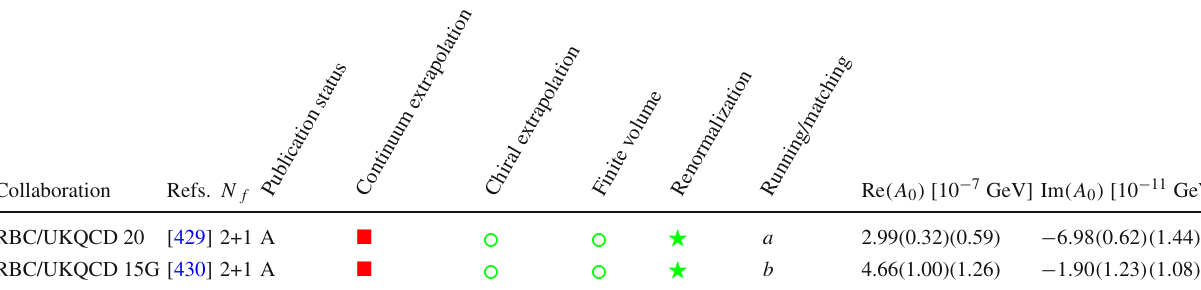
Table 28 Results for the real and imaginary parts of the K → ππ decay amplitude A 0 from lattice-QCD computations with N f = 2 + 1 dynamical flavours. Information about the renormalization, running and matching to the MS scheme is indicated in the column “running/matching”, with details given at the bottom of the table. We refer to the text for further details about the main differences between the lattice computations in Refs. [429] and